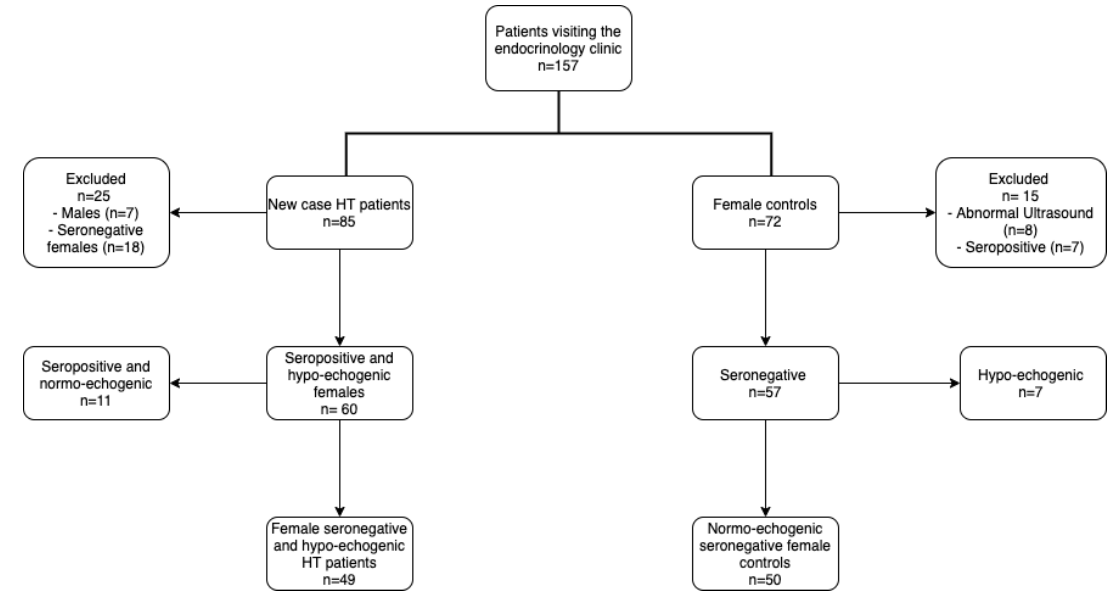
Figure 1. Patient and control enrollment process flowchart.